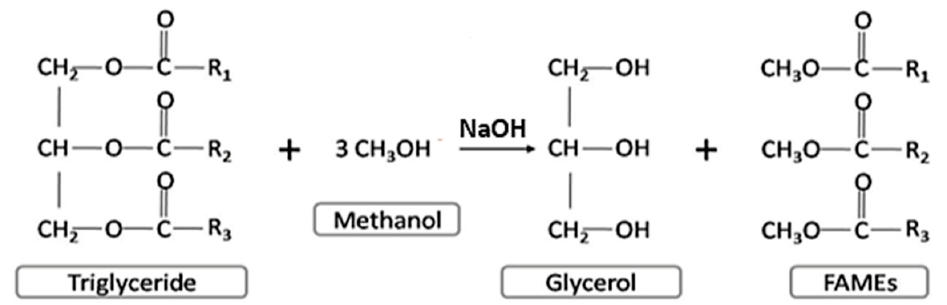
Figure 1. Reaction scheme for transesterification of triglycerides, modified from [26].